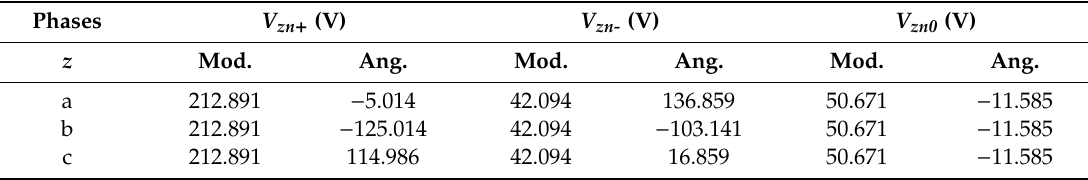
Table 1. Positive-, negative-, and zero-sequence voltages.